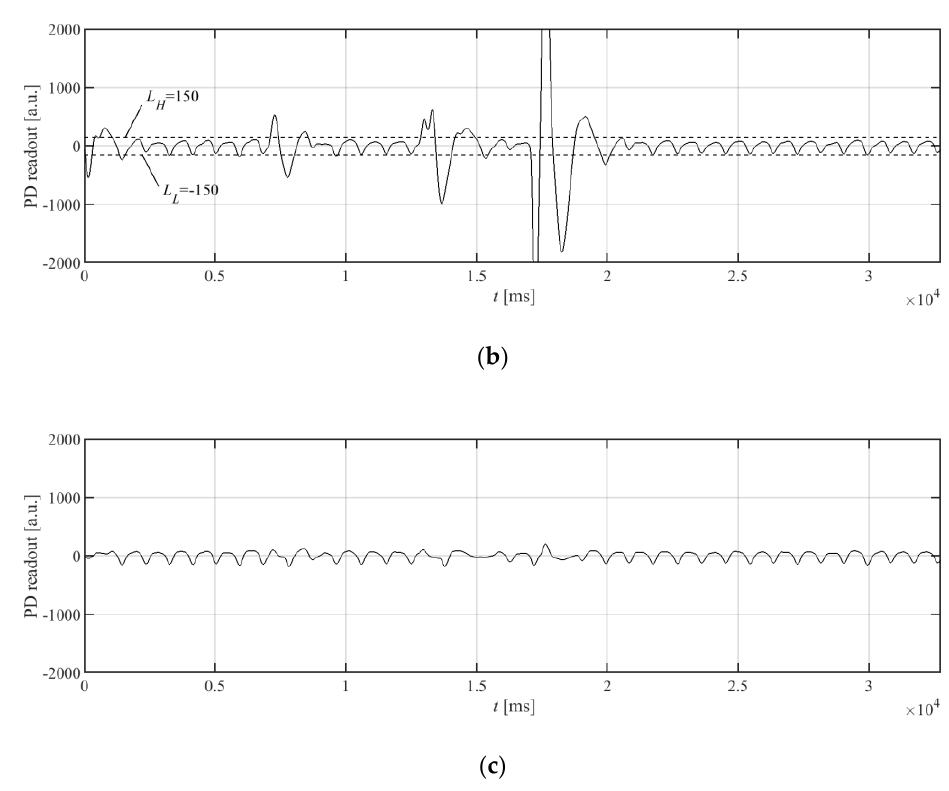
Figure 2. Waveforms of the signals from the PPG detector: ( a ) the raw signal; ( b ) the raw signal from ( a ) filtered only by a band-pass filter; and ( c ) the raw signal from ( a ) filtered first with the limiting section described in the paper and then by the same biquadratic filter as used in (b).